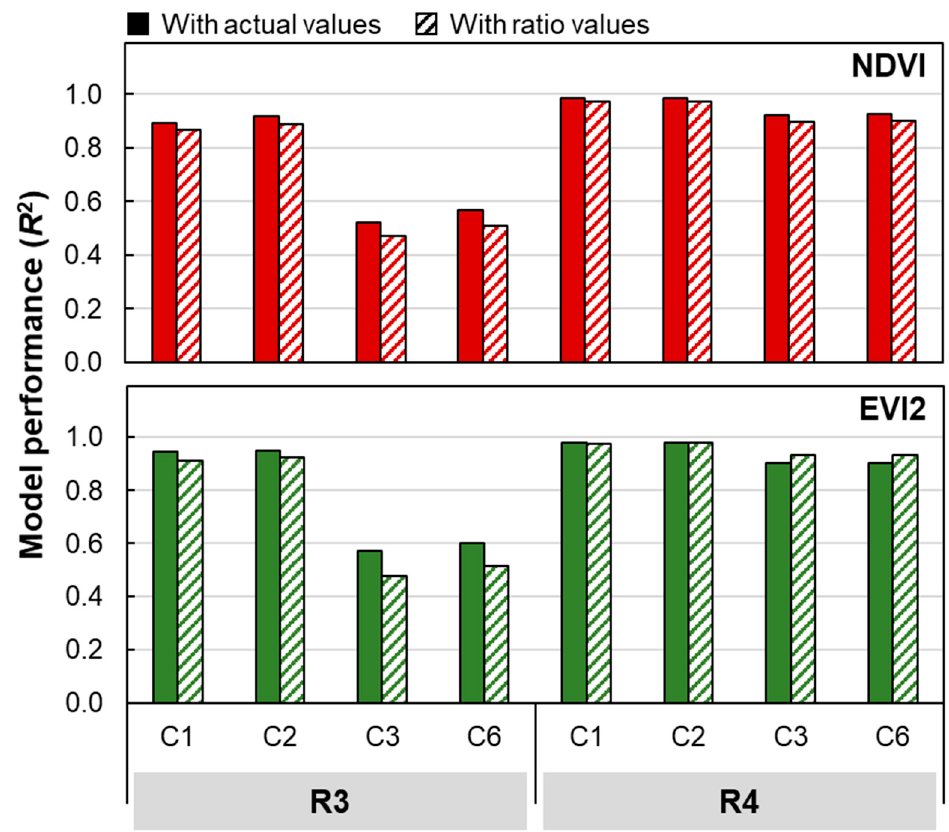
Figure 8. Comparison of corn yield estimation model performance with actual and ratio values of selected vegetation indices and selected sidedress treatment combinations from the UAS imagery obtained at R3 and R4. Note: C1 indicates zero-N + N-rich (all N applied at planting), C2 indicates zero-N + sidedressing at V4, C3 indicates zero-N + N-rich + sidedressing at V6, and C6 indicates zero-N + N-rich + V4 + V6.